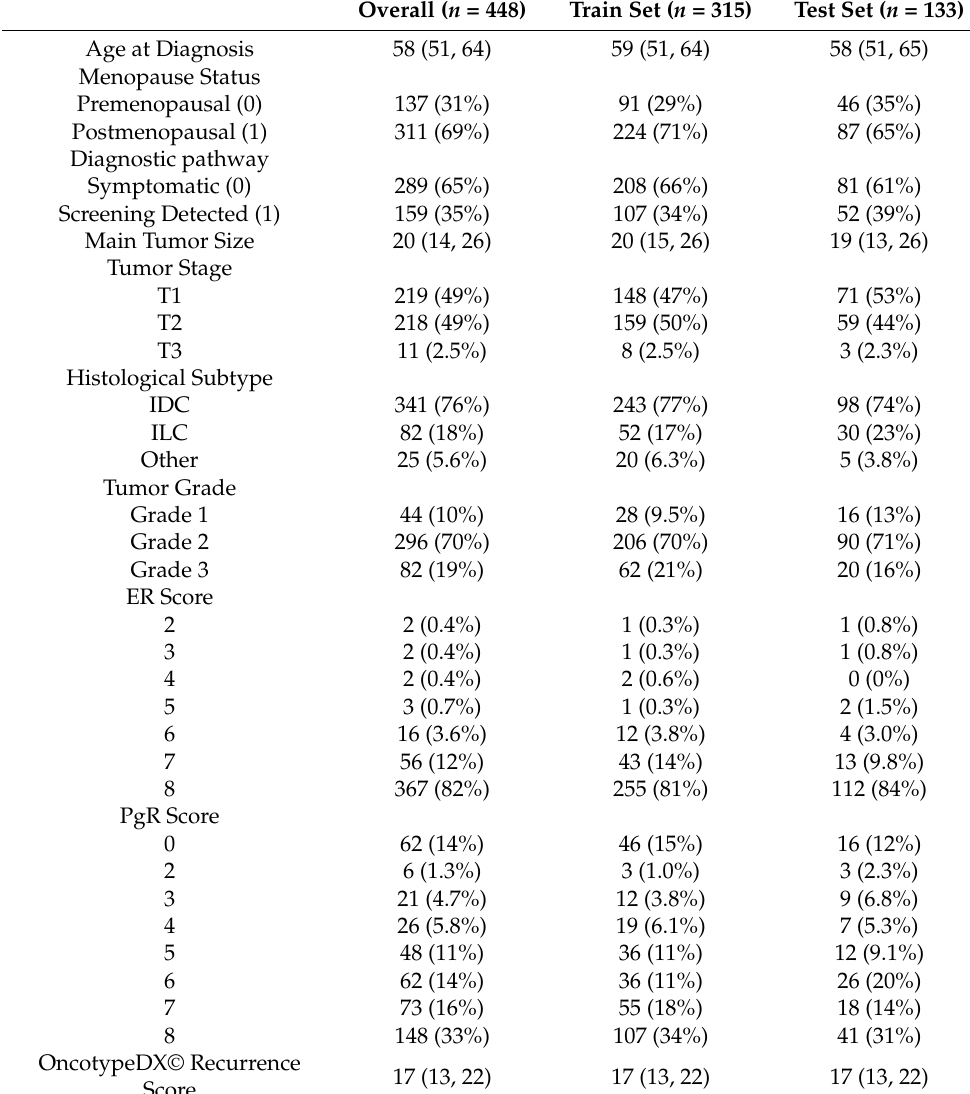
Table 1. Characteristics of the entire cohort with matched training and test